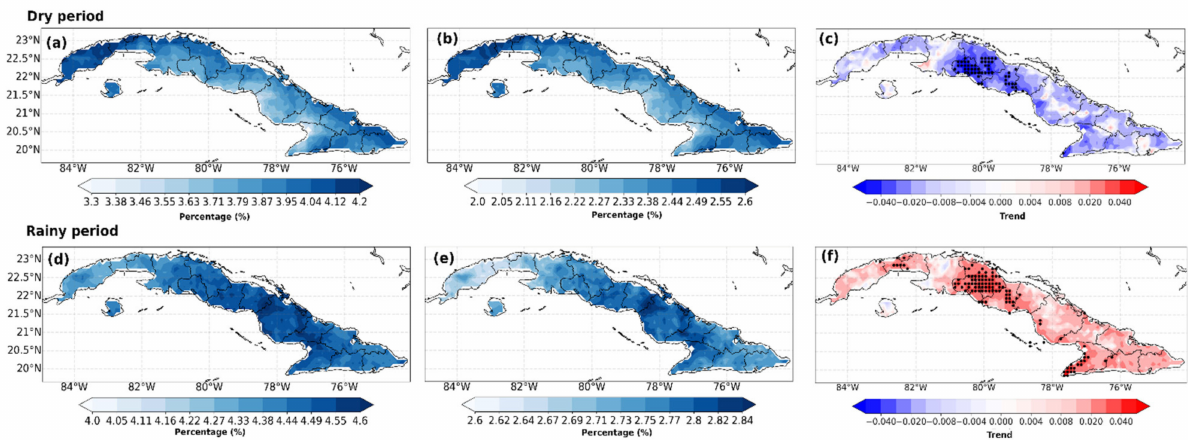
Figure 8. Percentage of occurrence of the extreme seasonal precipitation events with respect to the total number of days with extreme events ( a , d ). Percentage of occurrence of the extreme seasonal event with respect to the number of rainy days (>1 mm) ( b , e ). Trend of the number of extreme precipitation events ( c , f ). The upper and lower row corresponds to the dry and rainy periods, respectively. Black points show statistically significant trends ( p < 0.05). Period 1980–2019.